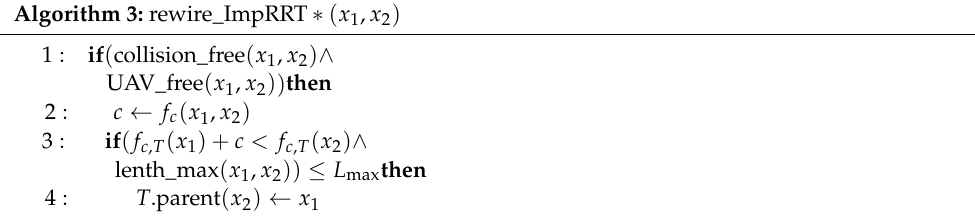
Algorithm 3: rewire_ImpRRT ∗ ( x 1 , x 2